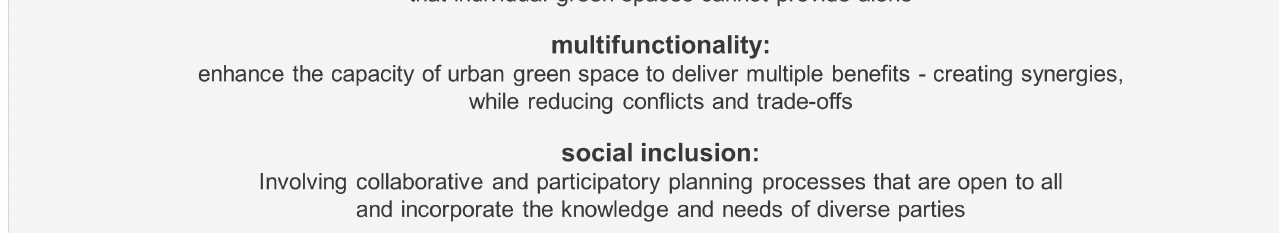
Figure 1. Scheme illustrating the understanding of UGI planning as conceptualized by the GREEN SURGE project (adapted from Hansen et al.,